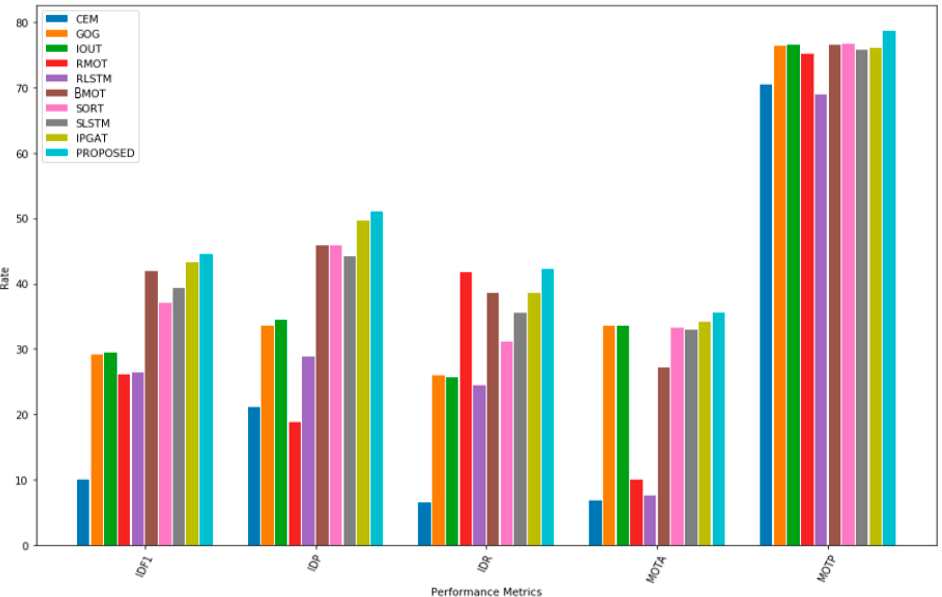
Figure 10. Comparative analysis of proposed method with existing methods. CEM: continuous energy minimization, GOG: global optimal greedy, IOUT: intersection-over-union tracker, RMOT: relative motion online tracking, RLSTM: relative long short term memory, Bayesian multi-object tracking (BMOT), SORT: simple online and real-time tracking, SLSTM: social long short term memory.